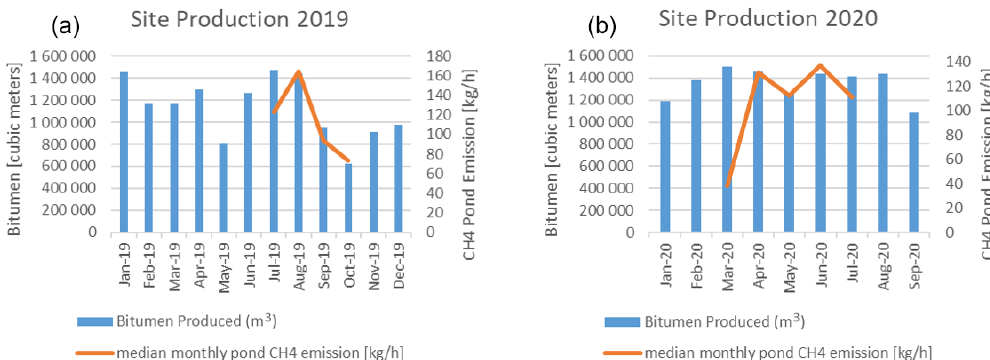
Figure 8. Bitumen production and GreenLITE ™ CH 4 tailings pond median monthly computed emissions (Alberta Energy Regulator, 2021).